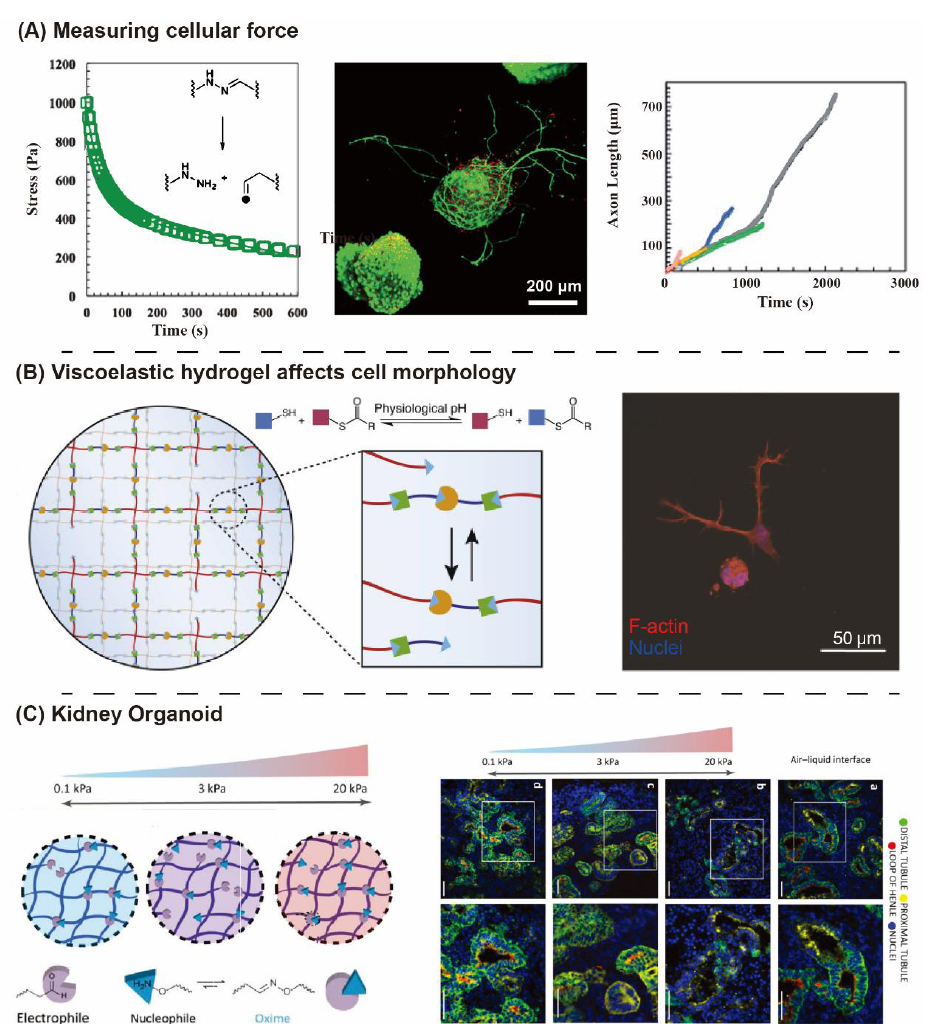
Figure 5. Applications of viscoelastic dynamic covalent hydrogels. ( A ) Stress relaxation of dynamic hydrazone crosslinks allows motor neurons to extend axon bodies into the hydrogels [127]. Copyright © The Royal Society of Chemistry 2014 ( B ) Thioester exchange facilitates spreading, proliferation, and migration of hMSCs in 3D scaffolds [57]. Copyright © 2018 Elsevier Ltd. ( C ) Oxime hydrogels were used to culture kidney organoids [126].